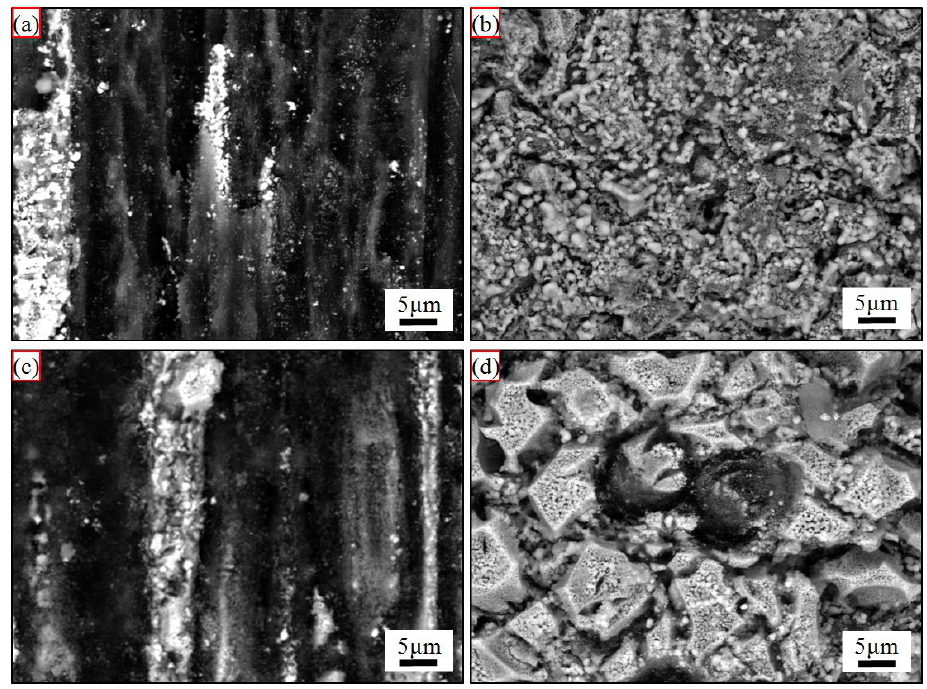
Figure 7. Surface morphologies of the ablated C/C-SiC-ZrC corresponding to the region II in Figure 3: ( a , b ) under C 0.5 ; ( c , d ) under C 5 ; ( a , c ) non-woven layer; and ( b , d ) web layer.